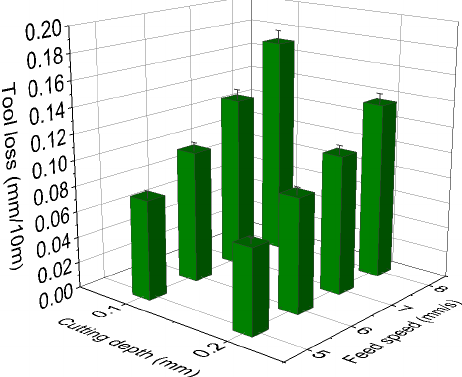
Figure 12. Tool loss amount of verification experiment.